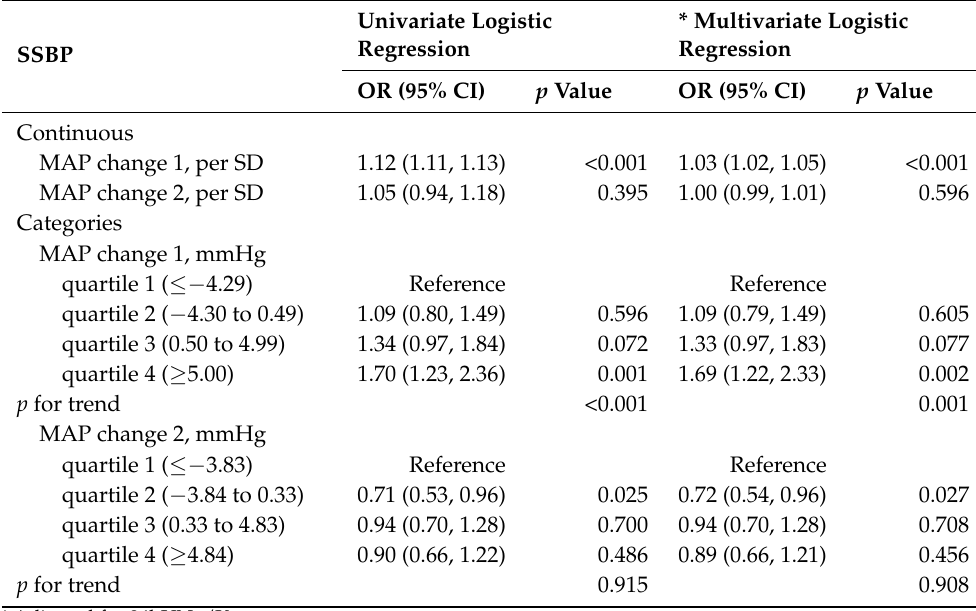
Table 2. Association of SSBP with 10-year CVD